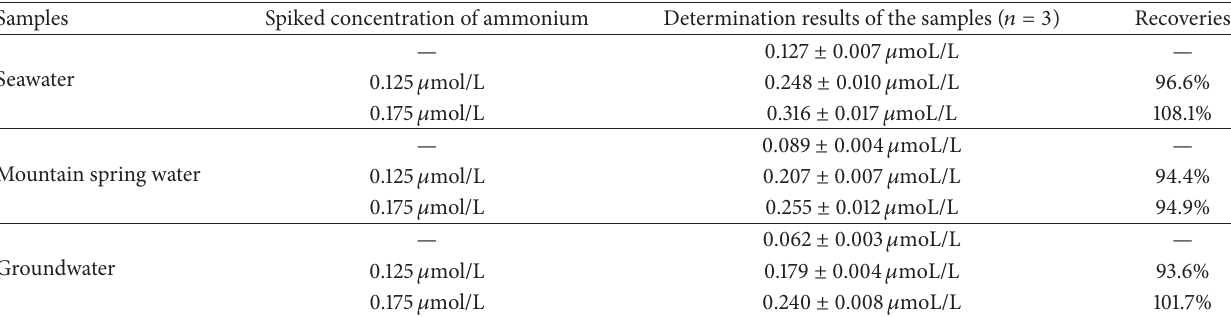
Table 3: The matrix spiked recoveries of the proposed